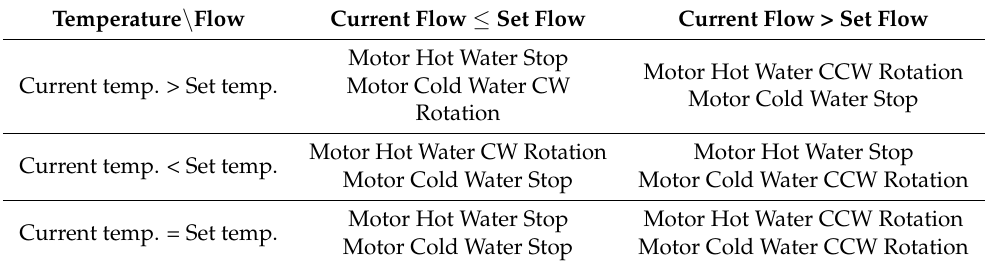
Table 4. Possible movements of stepper motors responsible for water flow and temperature control.